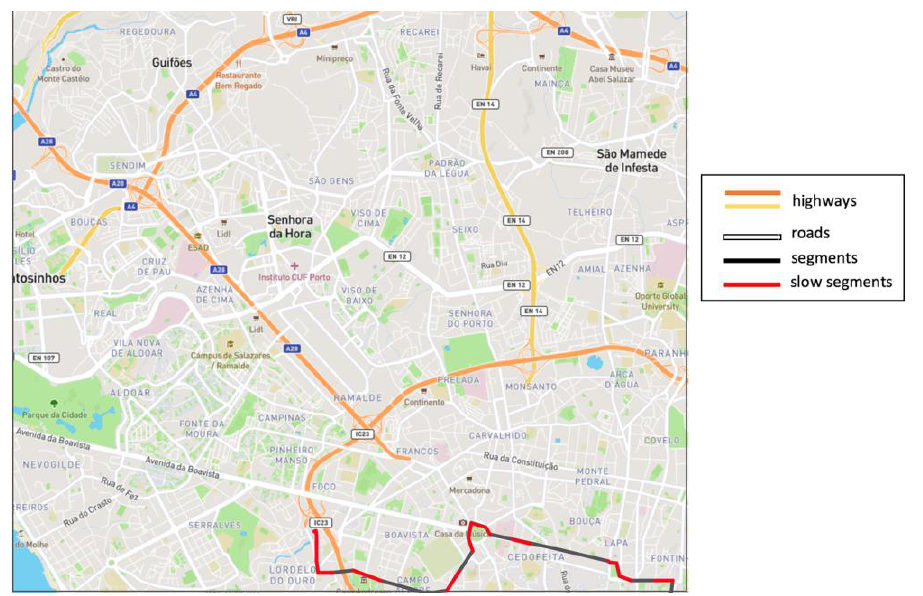
Figure 18. Slow segments (in red) of a trajectory with Maxspeed = 60 km/h, 6 August 2013 8:00:00 – 10:00:00.